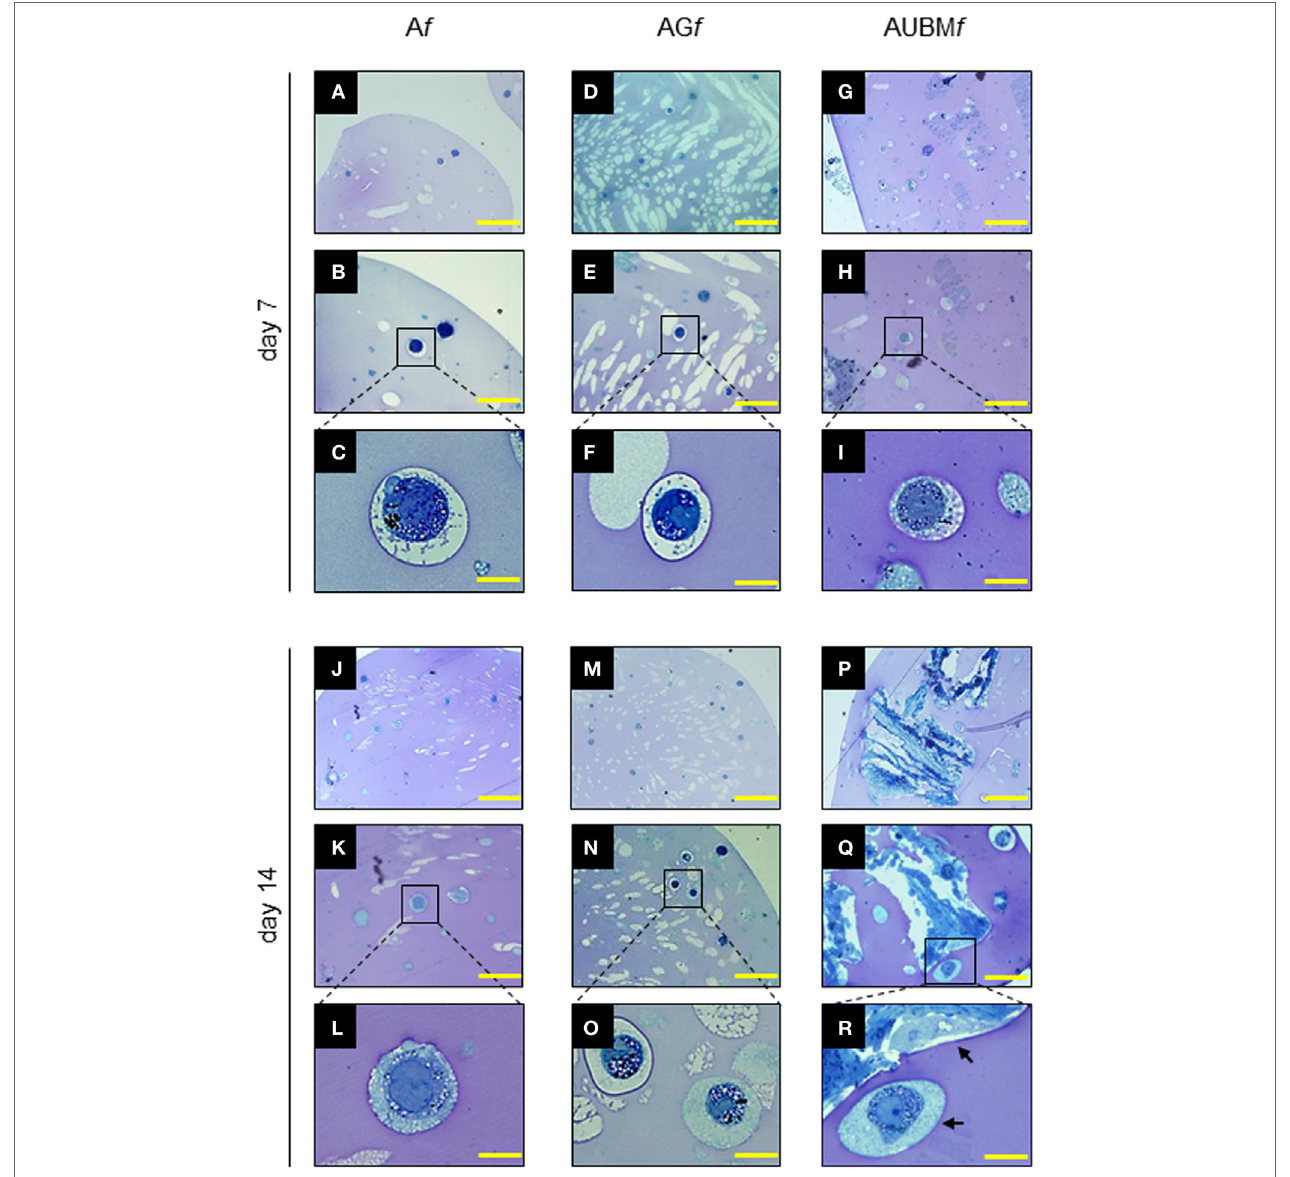
FigUre 4 | Properties of the embedded cells: presence of secretory vesicles and metachromatic areas in the extracellular matrix (ECM). A f , AG f , and AUBM f embedded cells at days 7 and 14 of culture were stained with toluidine blue. Representative photomicrographs showed the presence of ECM deposition in the pericellular space of the single cells (as clearly evidenced in the higher magnification images) and the presence of metachromatic area (pink). Black arrows: single or UBM-attached cell. Bar corresponds to 50 µm for photomicrographs (a,D,g,J,M,P) , to 25 µm for photomicrographs (B,e,h,K,n,Q) , and to 10 µm for photomicrographs (c,F,i,l,O,r)